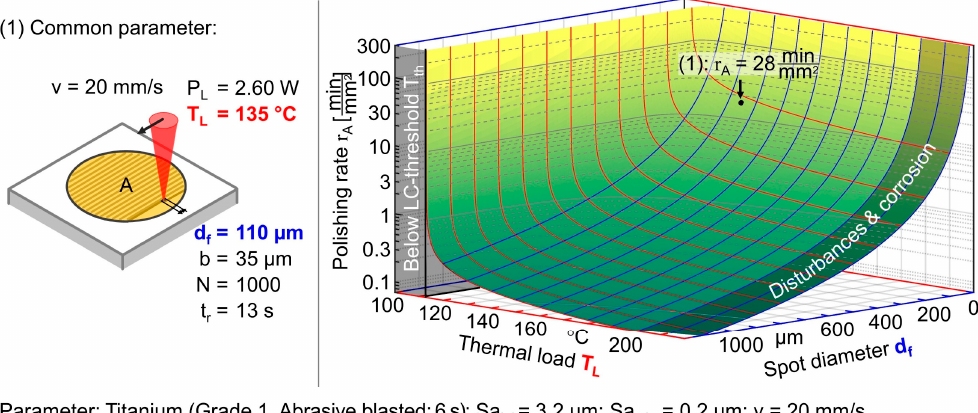
Figure 15. Polishing time depending on the thermal load and spot diameter.